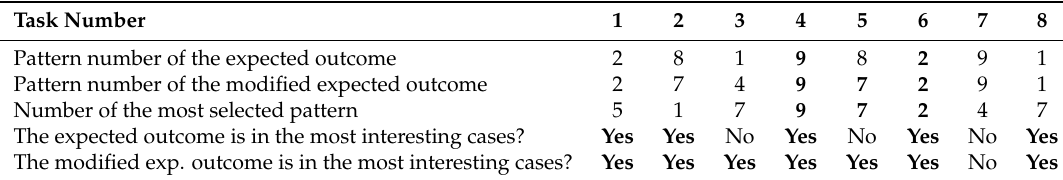
Table 5. Development direction of